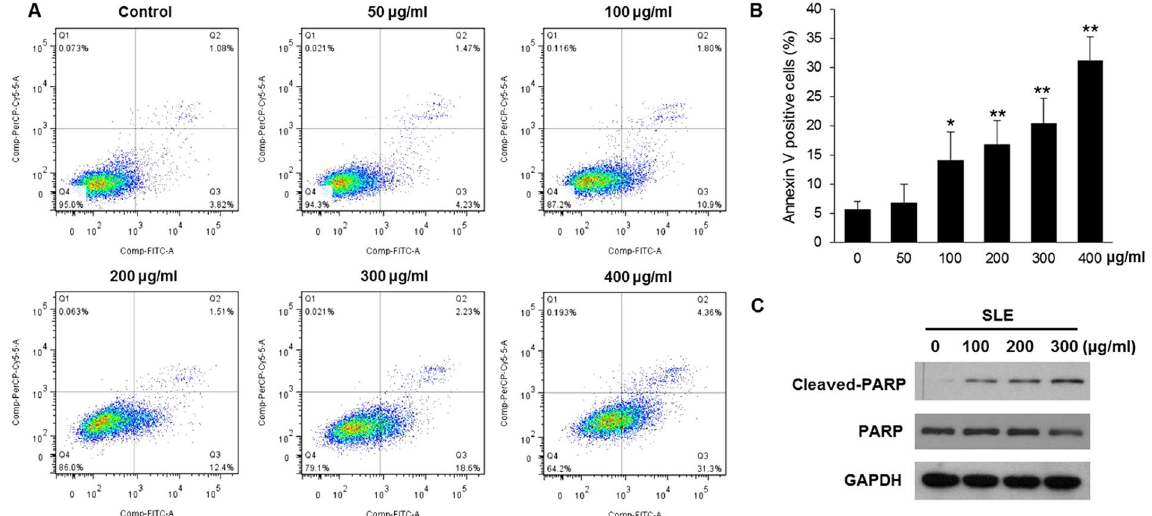
Figure 3. Pro-apoptotic effects of SLE on A375 melanoma cells. Cells were treated with the indicated concentrations of SLE for 48 h. ( A ) Representative flow cytometry plots of cell apoptosis. Apoptosis was analyzed using the Annexin V/7-AAD double staining assay. ( B ) The percentage of apoptotic cells after SLE treatment. Data were shown as means ± SD of three independent experiments. * P < 0.05, ** P < 0.01 versus control. ( C ) Effects of SLE on PARP cleavage in A375 cells. Protein levels were examined by immunoblotting and the cropped blots were shown. GAPDH was included as a loading control. Original uncropped western blot images were shown in Supplementary